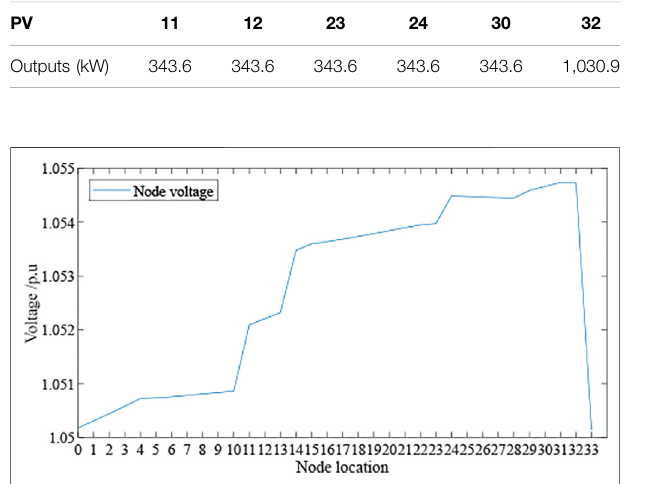
FIGURE 6 | Voltage pro fi le of 10 kV feeder at 13:00.